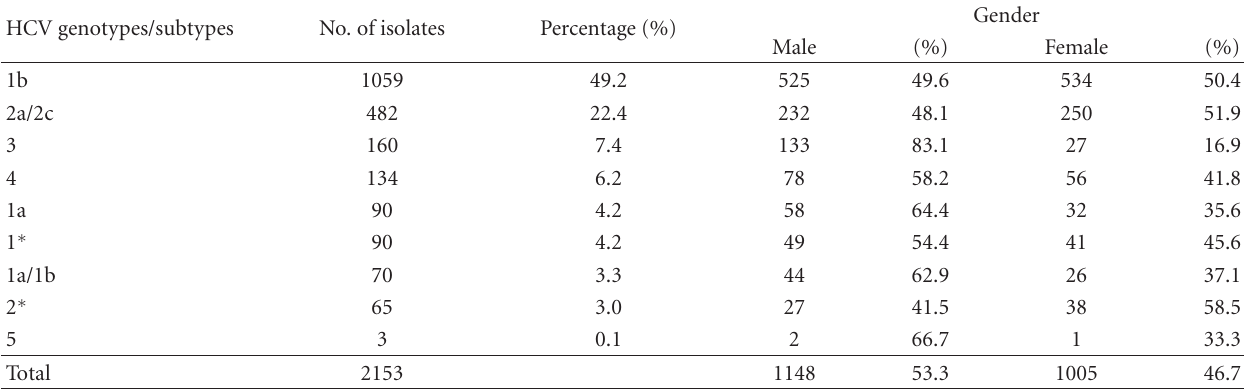
Table 2: HCV genotype/subtype distribution in the studied population ( n = 2,153), stratified by gender. HCV genotypes/subtypes